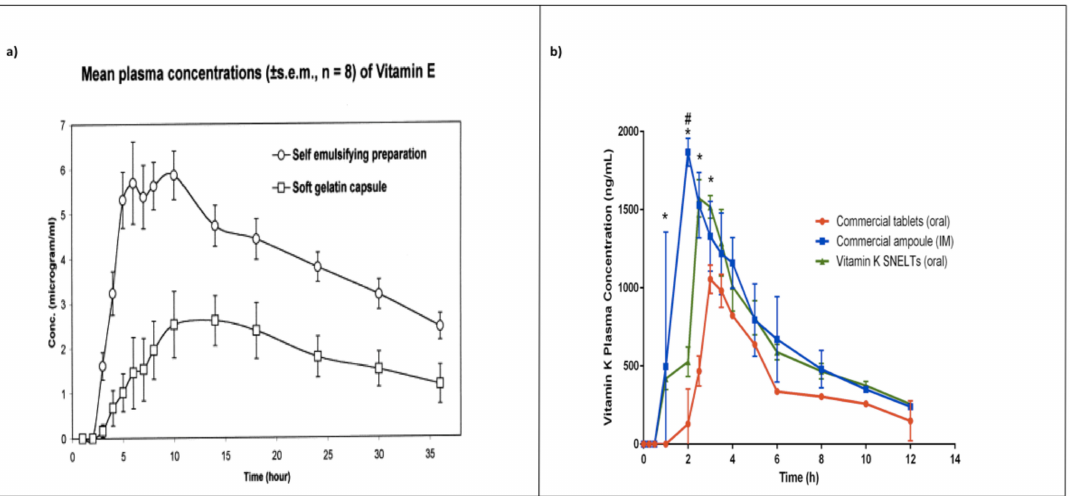
Figure 7. ( a ) Mean plasma concentration ( ± SEM, n = 8) of a-tocopherol as a function of